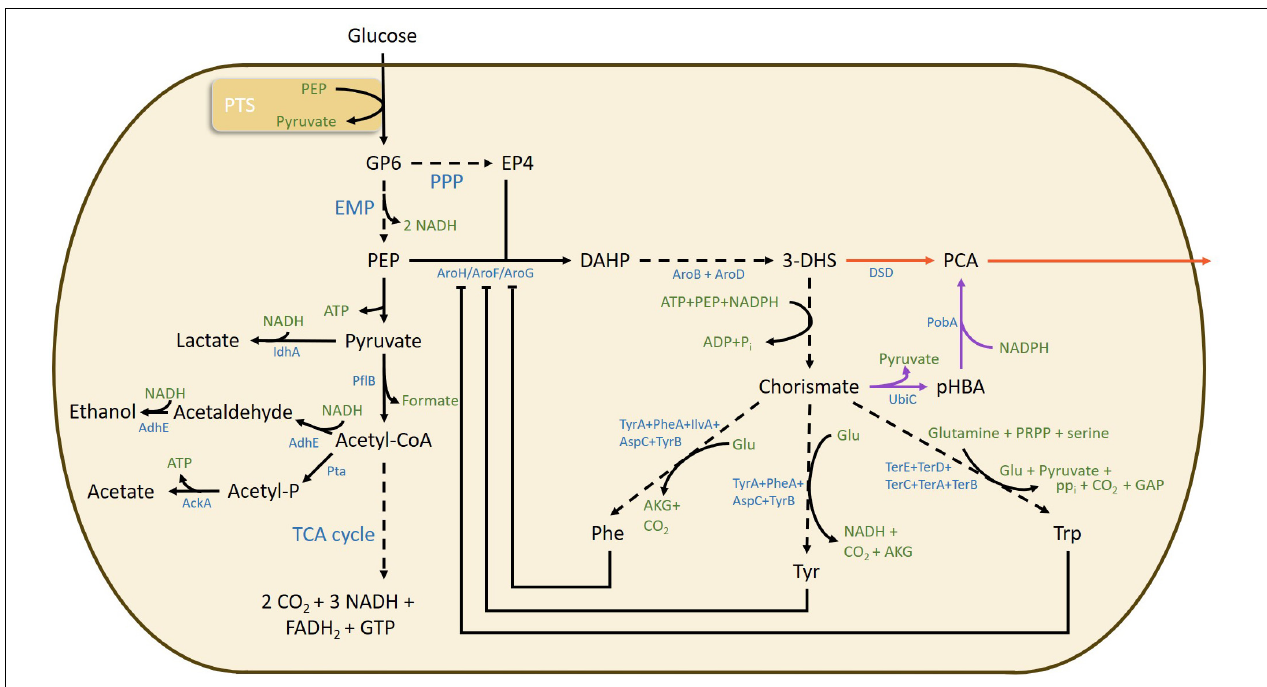
FIGURE 1 | Overview of relevant metabolic pathways, bottlenecks, metabolites, and enzymes involved in protocatechuic acid formation via both DSD (red arrow) and PobA/UbiC (purple arrow) from the shikimate pathway for aromatic amino acid metabolism in E. coli . Dashed arrows indicate a multistep enzymatic pathway. 3-dehydroshikimic acid, 3-DHS; acetate kinase, AckA; aldehyde/alcohol dehydrogenase, AdhE; α -ketoglutarate, AKG; 3-dehydroquinate synthase, AroB; 3-dehydroquinate dehydratase, AroD; 3-deoxy-7-phosphoheptulonate synthase, AroF, AroH, and AroG; aspartate aminotransferase, AspC; adenosine triphosphate, ATP; 3-dehydroshikimate dehydratase, DSD; erythrose 4-phosphate, E4P; 3-deoxy-D-arabino-heptulosonic acid 7-phosphate, DAHP; Embden–Meyerhof–Parnas, EMP; flavin adenine dinucleotide reduced form, FADH 2 ; glutamate, Glu; guanosine triphosphate, GTP; nicotinamide adenine dinucleotide reduced form, NADH; nicotinamide adenine dinucleotide phosphate reduced form, NADPH; protocatechuic acid, PCA; phosphoenolpyruvate, PEP; pyruvate formate-lyase, pflB; p-hydroxybenzoic acid, pHBA; phenylalanine, Phe; phosphate, P i ; pyrophosphate, PP i ; pentose phosphate pathway, PPP; p-hydroxybenzoate hydroxylase, PobA; 5-phosphoribosyl 1-pyrophosphate, PRPP; phosphate acetyltransferase, Pta; tricarboxylic acid cycle, TCA cycle; tryptophan, Trp; tyrosine, Tyr; tyrosine aminotransferase, TyrB; chorismate lyase,